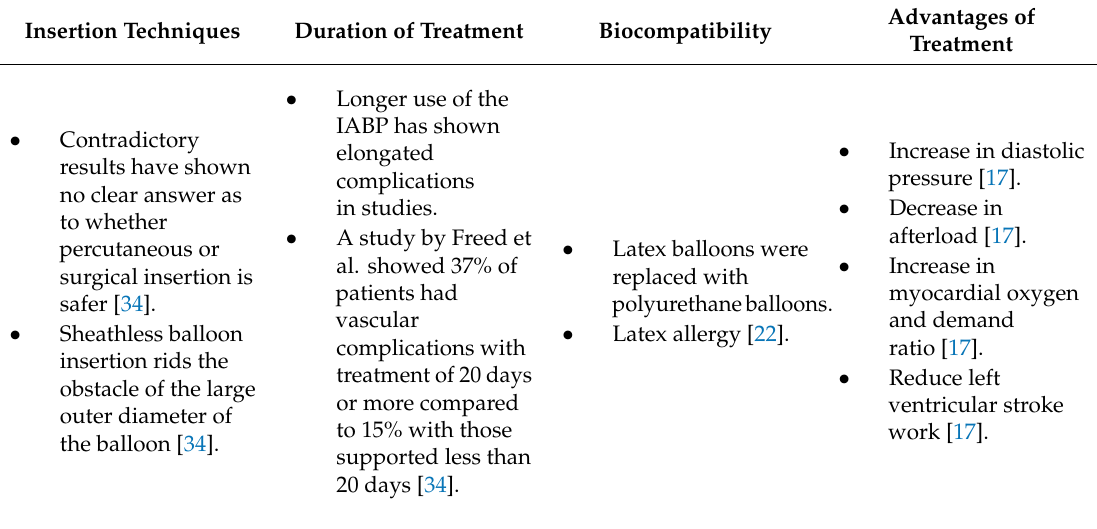
Table 2. Technical Complications and